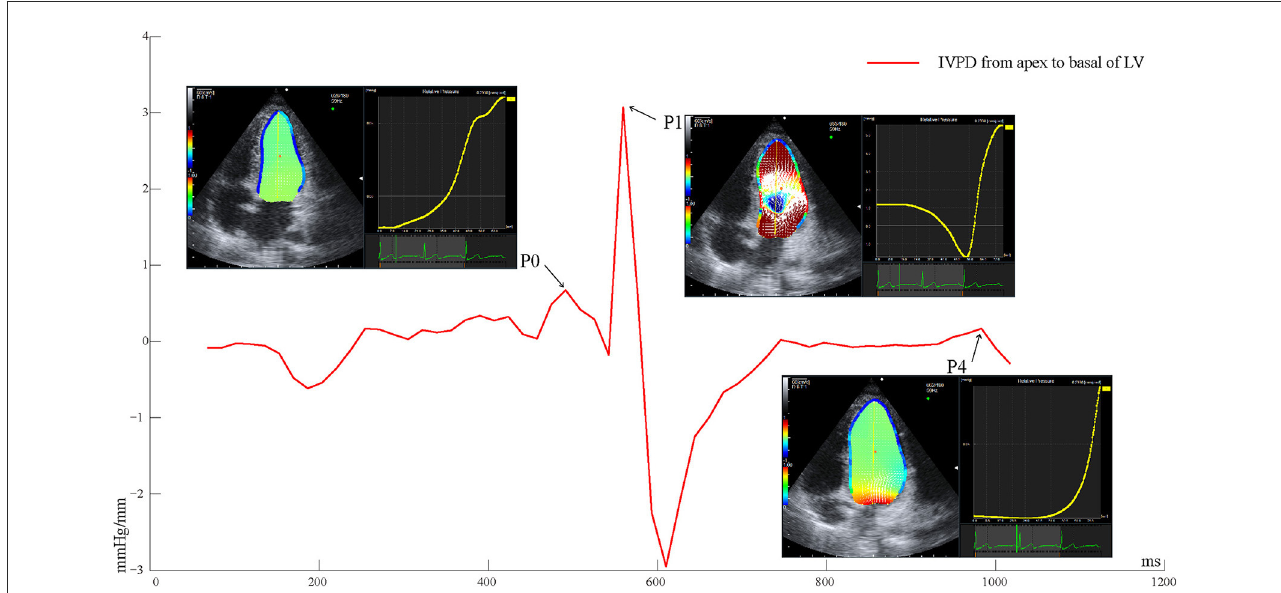
FIGURE1 Time-IVPD curves of LV apical to basal of one cardiac cycle. LV, left ventricular; IVPD, intraventricular pressure difference; P0, isovolumic relaxation; P1, rapid filling; P4, atrial